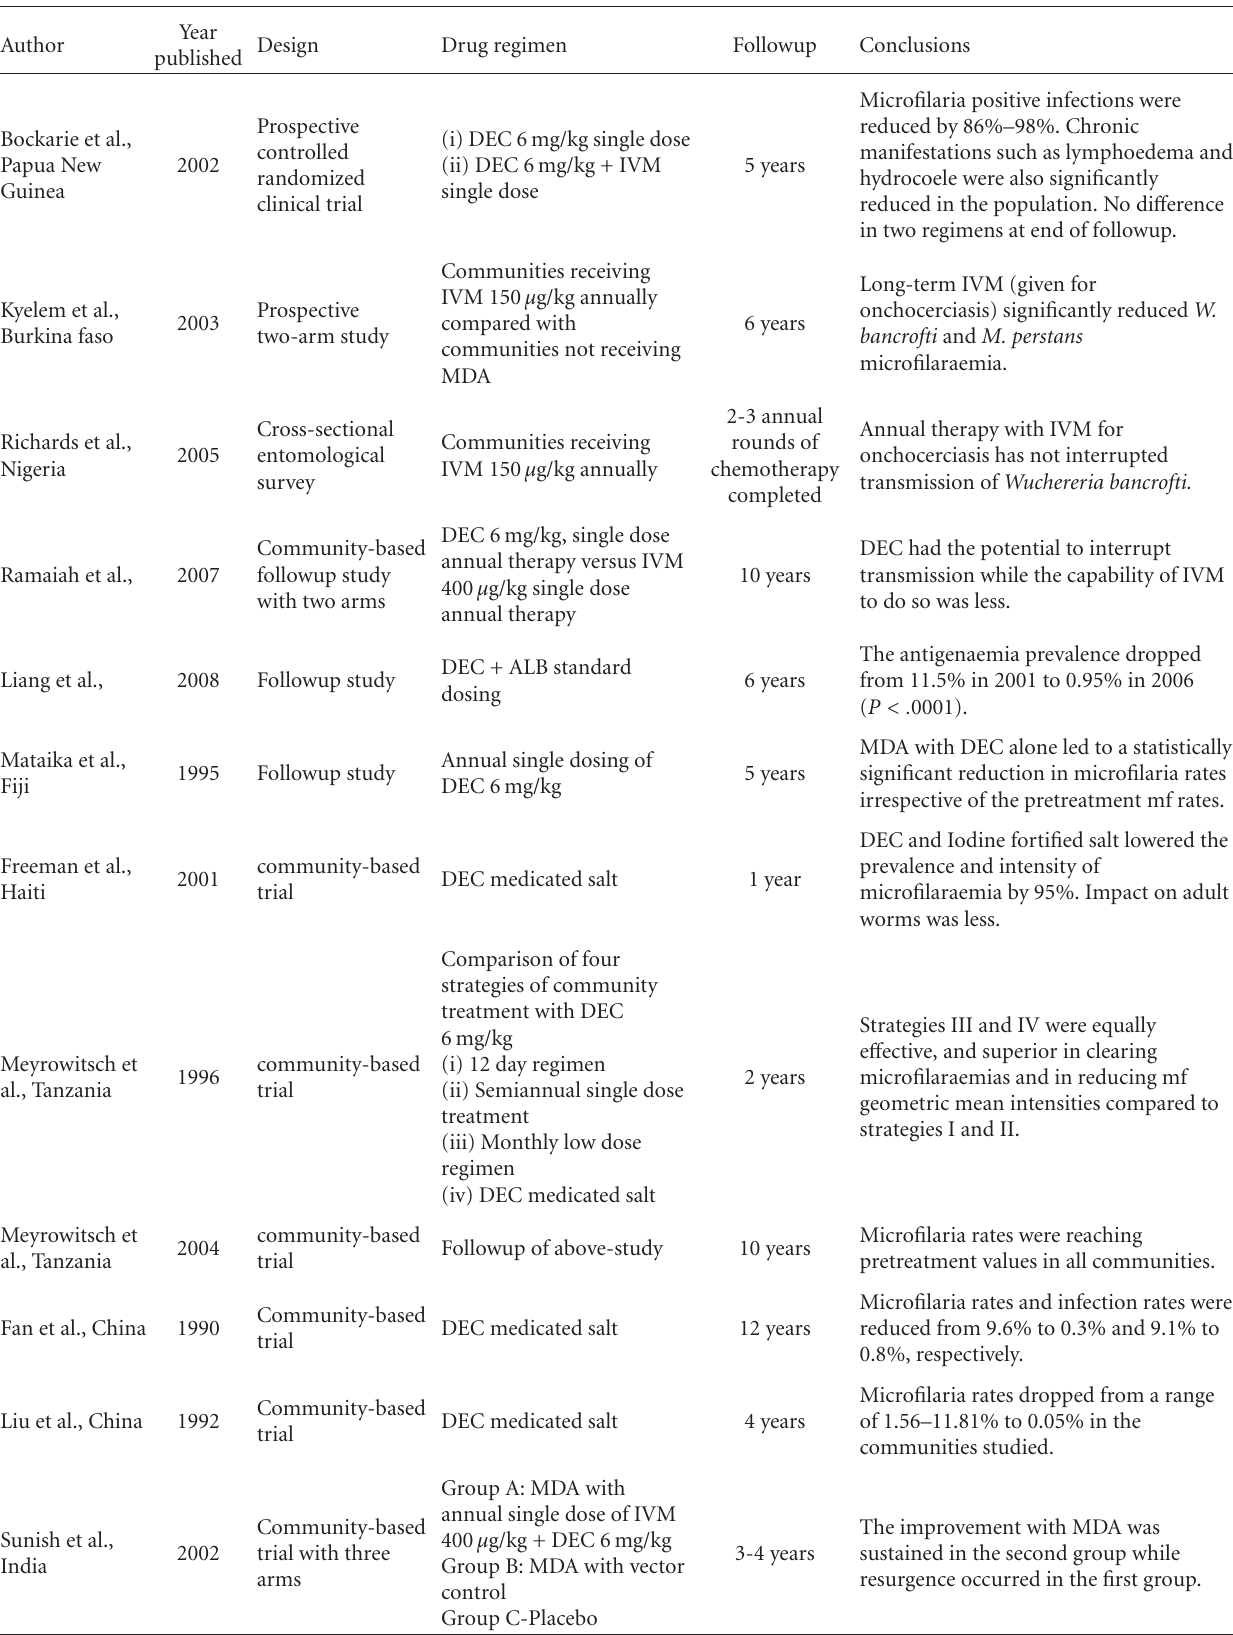
Table 2: Summary of followup studies on cohorts receiving mass drug